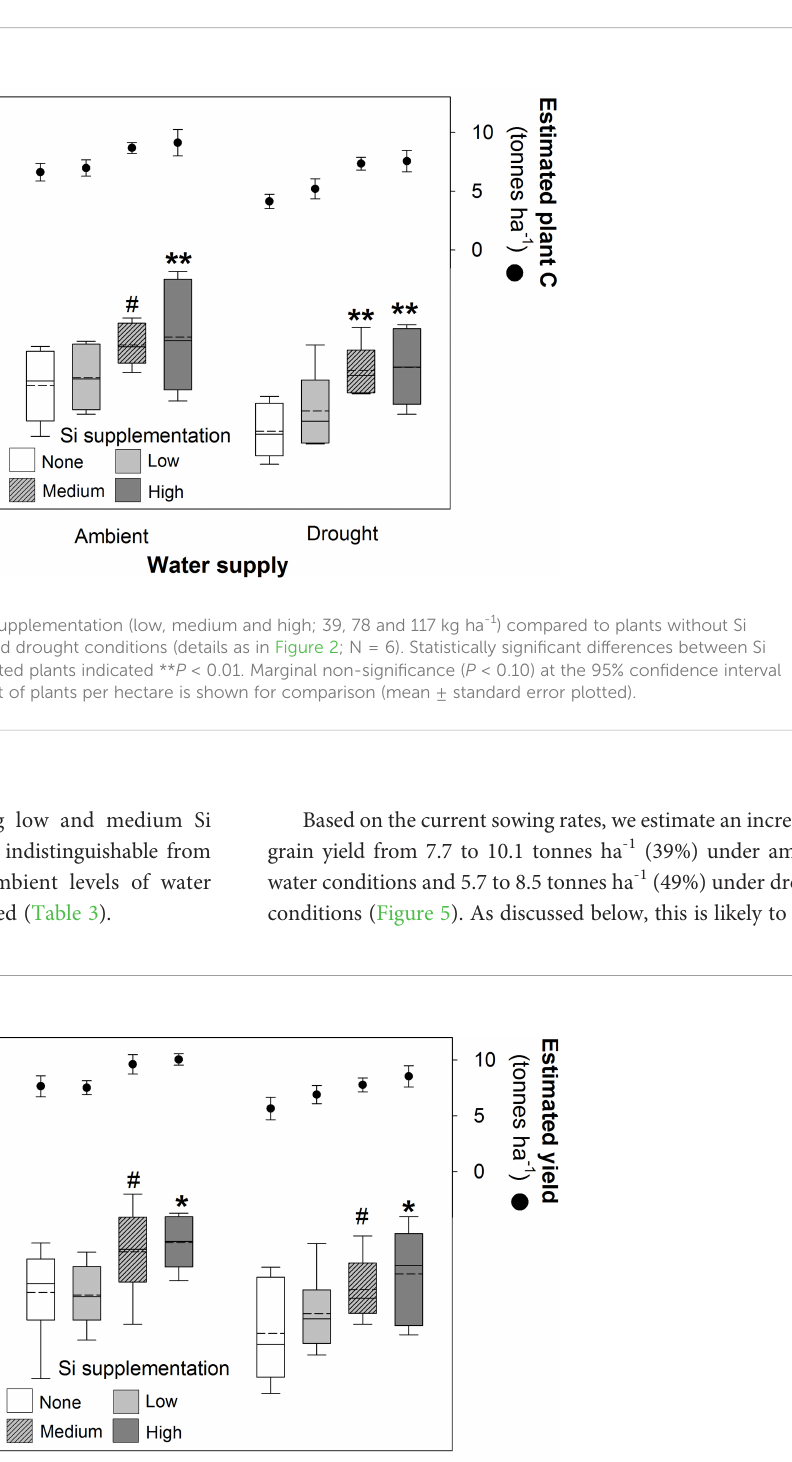
FIGURE 5 Grain mass of plants grown with Si supplementation (low, medium and high; 39, 78 and 117 kg ha -1 ) compared to plants without Si supplementation (none) under ambient and drought conditions (details as in Figure 2; N = 6). Statistically signi fi cant differences between Si supplemented plants and non-supplemented plants indicated as * P < 0.05. Marginal non-signi fi cance ( P < 0.10) at the 95% con fi dence interval indicated #. The estimated grain yield per hectare is shown for comparison (mean ± standard error